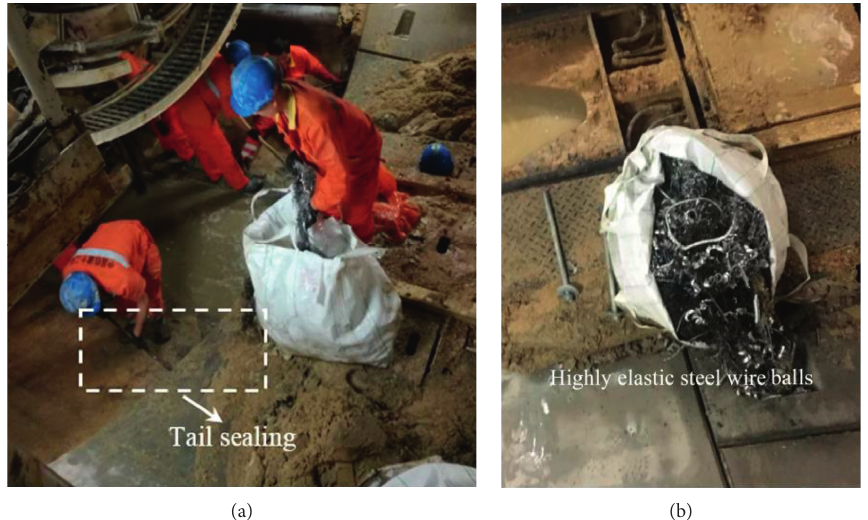
Figure 11: Shield tail sealing: (a) highly elastic steel wire balls are manually inserted into the tail of the shield; (b) photograph of the highly elastic steel wire balls.